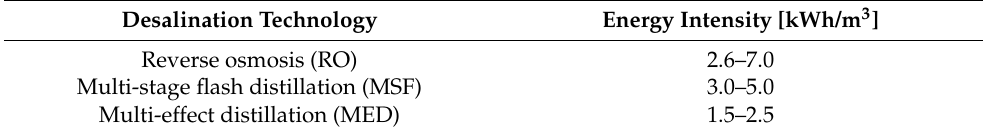
Table 11. Specific energy consumption for various desalination processes